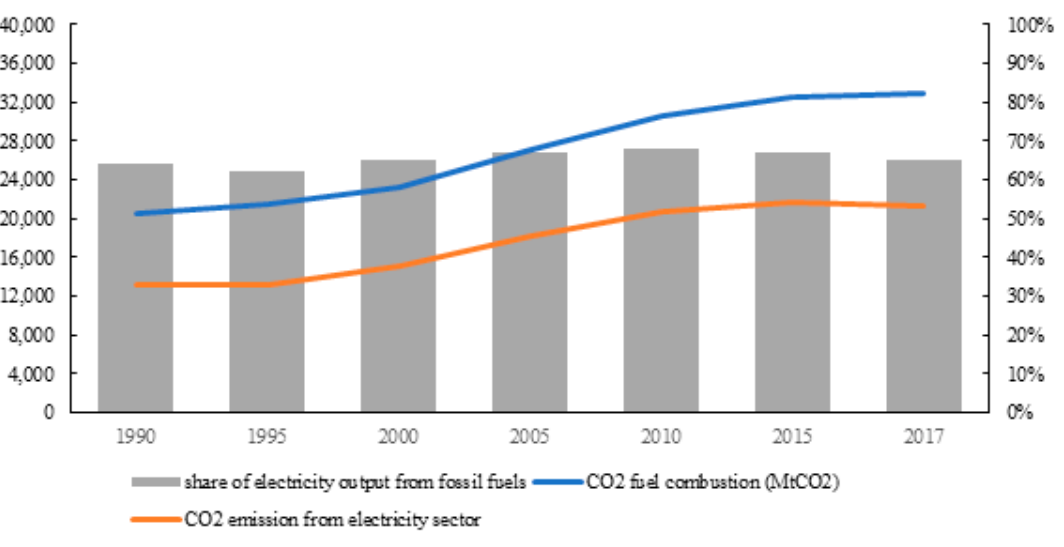
Figure 1. CO 2 emission from fuel combustion and the electricity sector [5]. 44